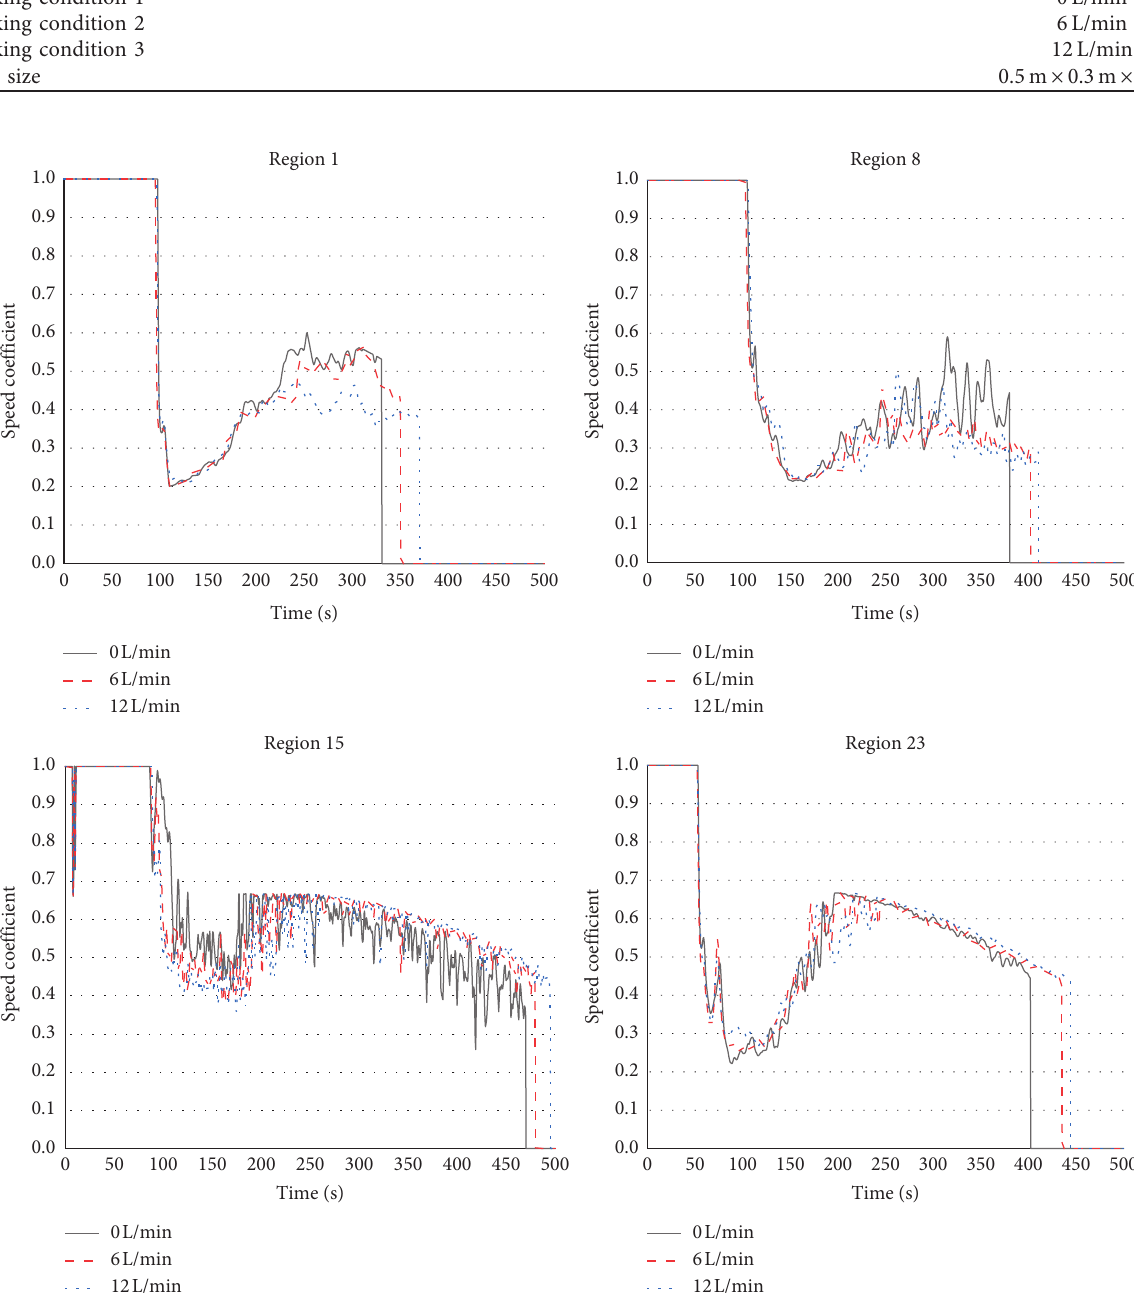
Figure 11: Effect of spray intensity on speed coefficient. Table 14: Smoke exhaust rate under different working